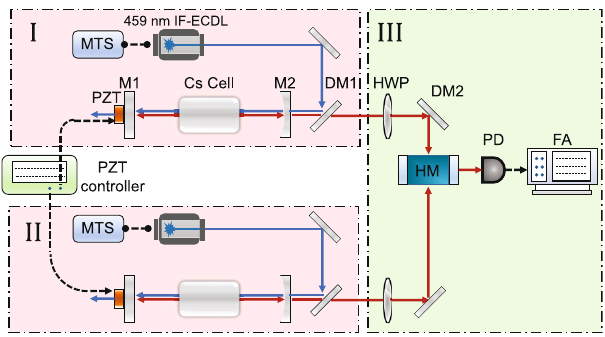
Fig. 4 Experimental setup of the heterodyne measuring system between